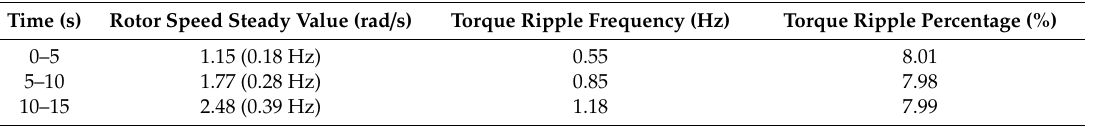
Table 1. Statistics of rotor speed and torque under wind